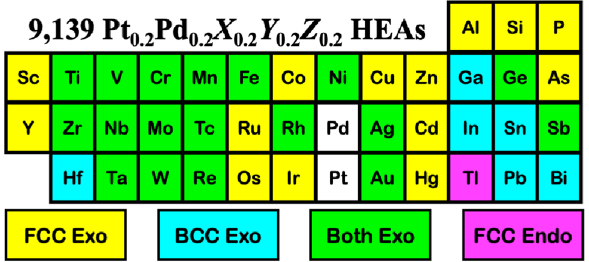
Figure 9. Predicted role of individual elements in the HEA formation energy and